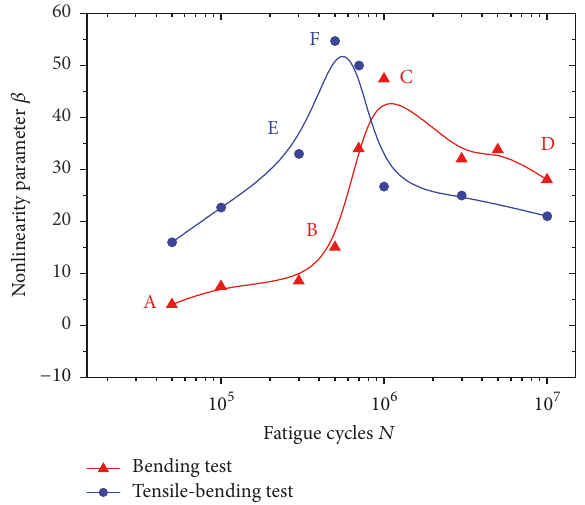
Figure 7: STFT spectrograms of KMN-I specimen Lamb wave sig- nals ( 𝑁 𝑓 = 5 × 10 6 ).